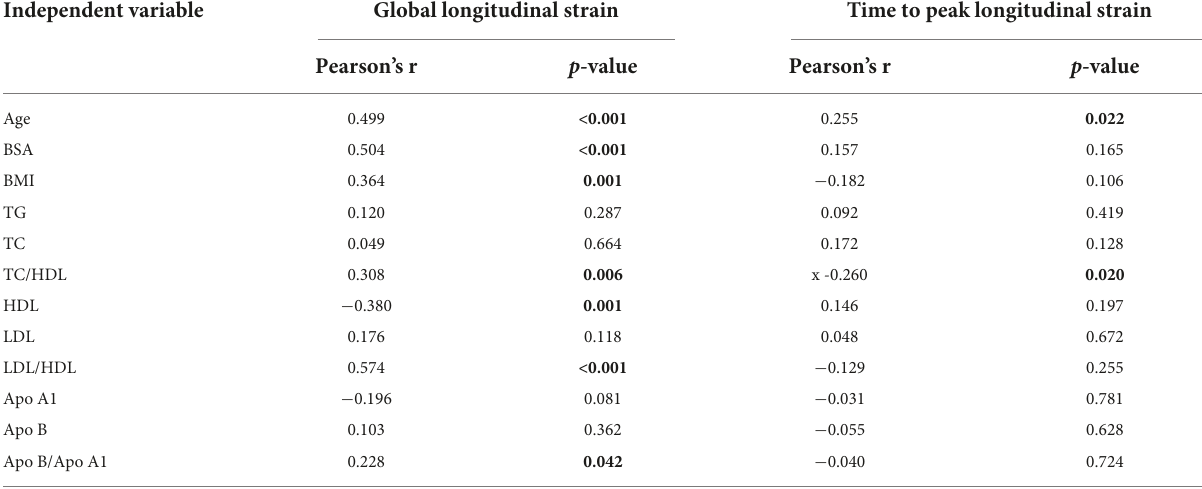
TABLE 4 Pearson correlation coefficient of LV global longitudinal strain and time to peak longitudinal strain of the SMA group. Independent variable Global longitudinal strain Time to peak longitudinal